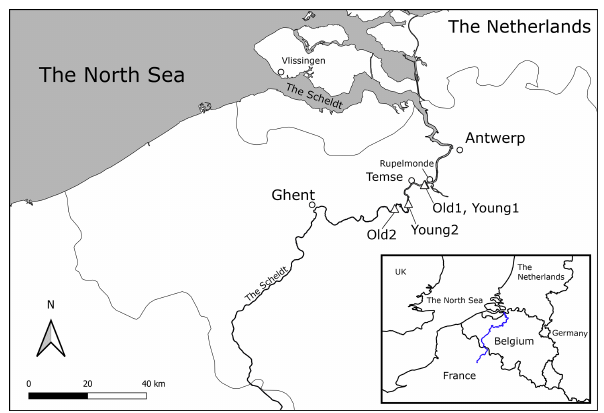
Figure 1. Map of the Scheldt estuary: triangles indicate the loca- tions of the sampled tidal marshes. Old1 and Young1 were only 250m apart, and on the scale of the map, they